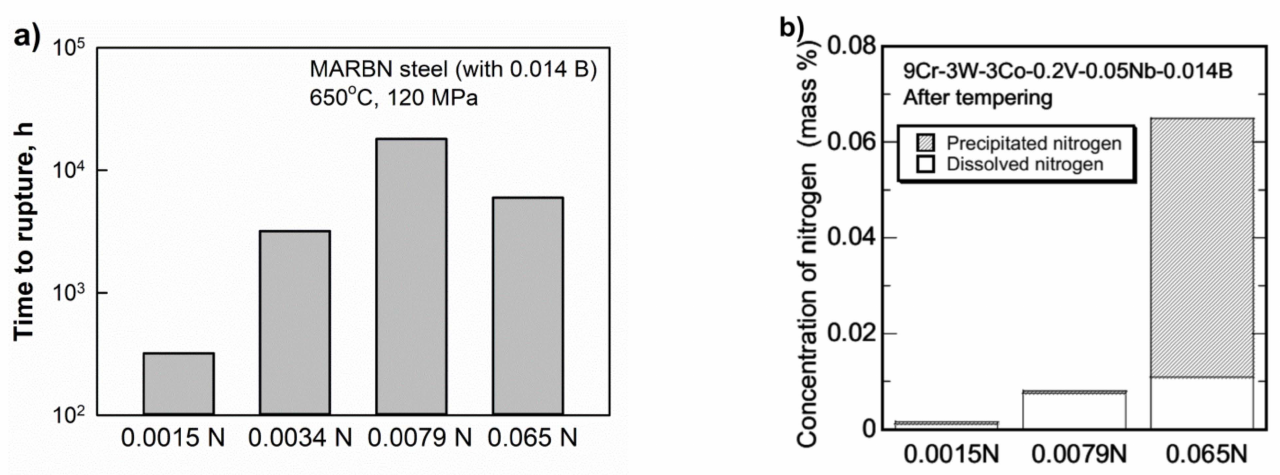
Figure 6. Effect of nitrogen on creep rupture time of MARBN (9Cr-3W-3Co-VNb) steel with 140 ppm boron at 650 ◦ C ( a ). Data are from Ref. [11]. Dissolved and precipitated nitrogen concentration in the 0.0015 N, 0.0079 N, and 0.065 N MARBN steels after tempering ( b ). Reprinted with permission from Ref. [26]. Copyright 2008 ASM International. Table 2. Creep rupture time of P91 steel with different B/N contents at 120 MPa, 650 ◦ C, and the maximum volume fractions of phases predicted by Thermo-Calc software. Data from [66]. Volume Fraction of Phase, % Time to B/N Content in P91 Steel, Rupture, h in ppm. MX M 23 C 6 M 23 (B,C) 6 70 ppm B/108 ppm N 770 0.0017 0.0299 0.002 100 ppm B/20 ppm N 296 0.0008